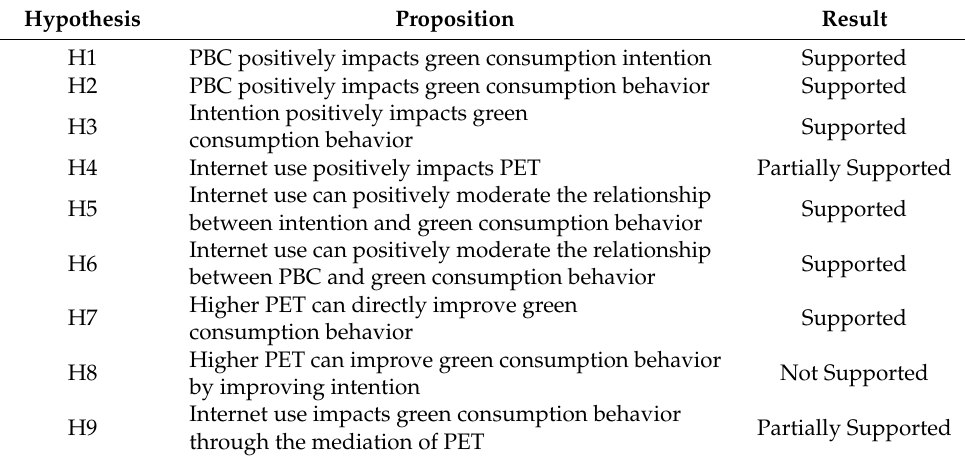
Table 8. Hypotheses Test